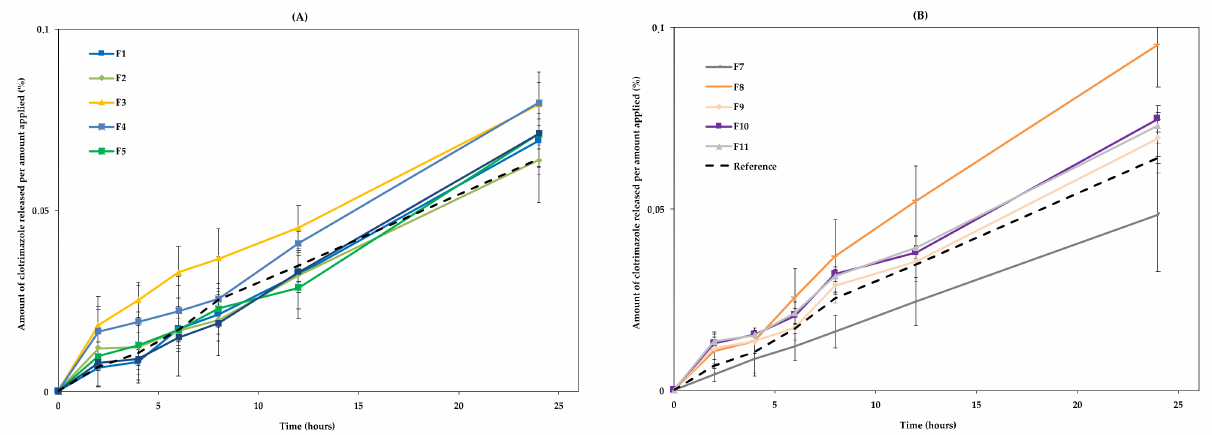
Figure 5. Drug permeation profile through newborn pig skin: ( A ) F1–F6 and RF; ( B ) F7–F11 and RF. The results are mean ± SD, n =